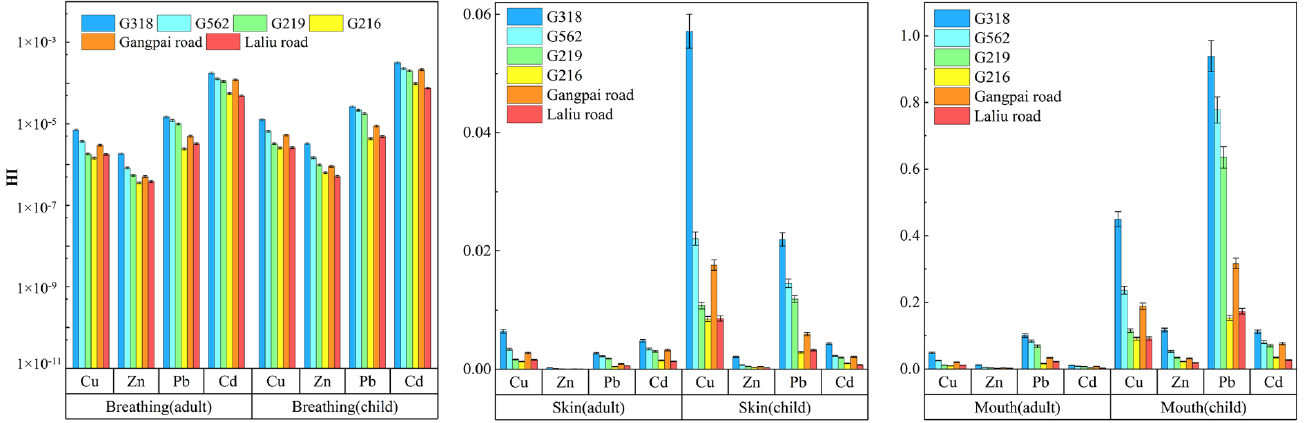
Figure 8. Non-carcinogenic risk from soil heavy metals found near different roads for children and adults.